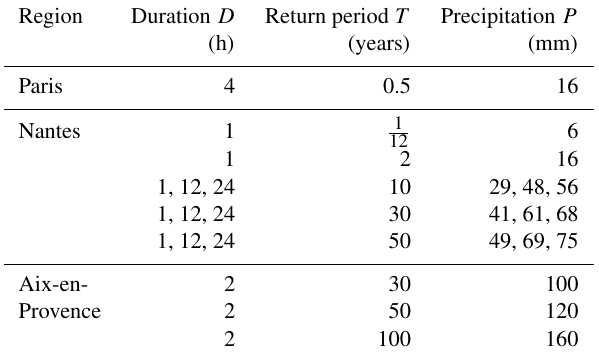
Table 2. Variability of reference rainfall regulations in the three re- gions considered by this study.